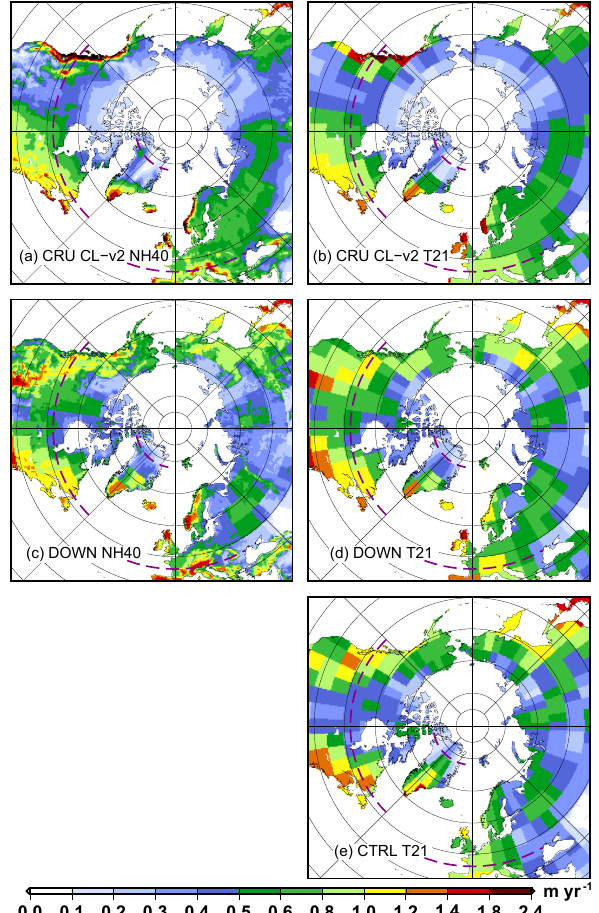
Figure 6. Northern Hemisphere annual mean precipitation rate (myr − 1 ) in: CRU CL-v2 (a, b) , the i LOVECLIM that includes a downscaling ( c, d ; with z q = 2000m, α min q = 0 . 8 and f s = 0 . 6) and the standard version of i LOVECLIM ( e , CTRL). The left panels (a, c) corresponds to data on the high-resolution grid, whilst on the right (b, d, e) data are aggregated to the T21 resolution. The dashed purple lines identify the selected transects used for